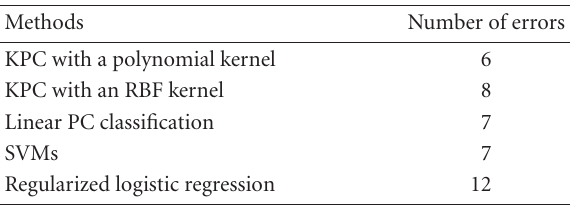
Figure 1. Output of the test data with KPC classification algo- rithm. Table 1. Comparison for lung cancer.